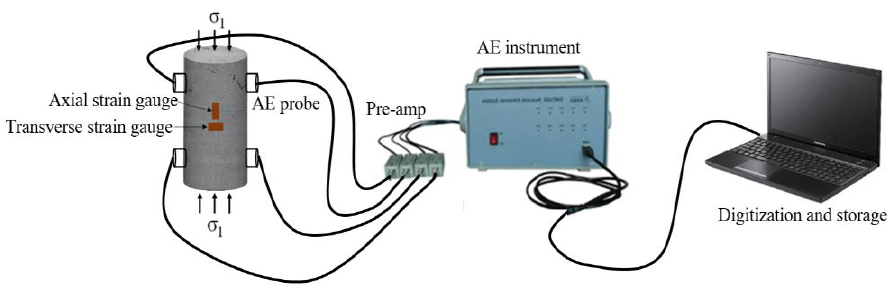
Figure 2. Schematic diagram of AE test system for rock samples.